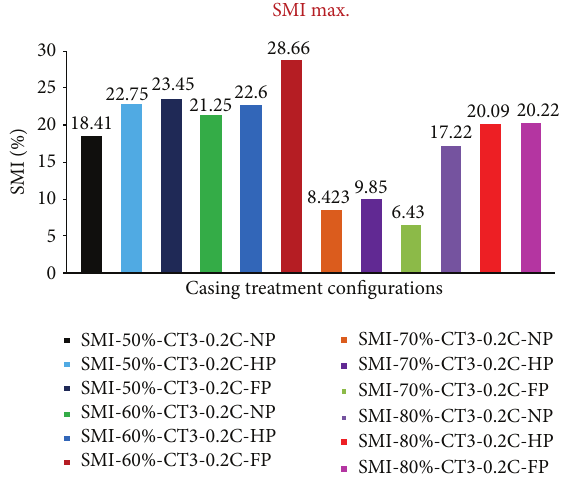
Figure5:Stallmarginimprovementswithcasingtreatment-plenum chamber configurations at 20% axial coverage.